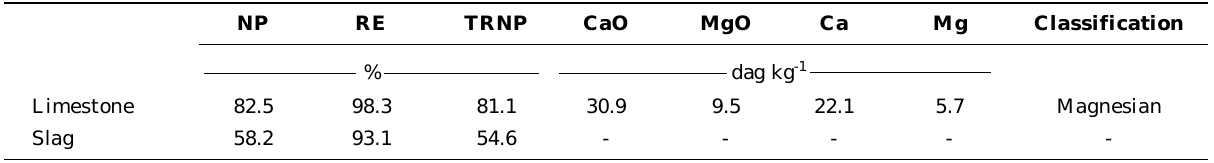
Table 4. Neutralization Potential (NP), Relative Efficiency (RE) and Total Relative Neutralization Potential (TRNP) of limestone and steel slag